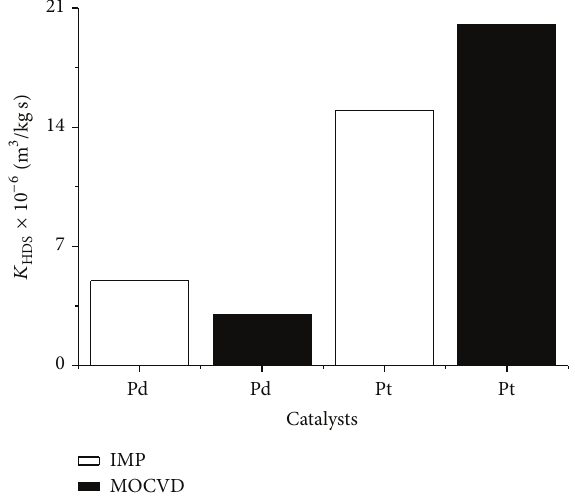
Figure 5: Pseudo-first-order HDS intrinsic kinetic constants over monometallic Pt and Pd catalysts ( 𝑃 = 5.59 MPa, 𝑇 = 350 ∘